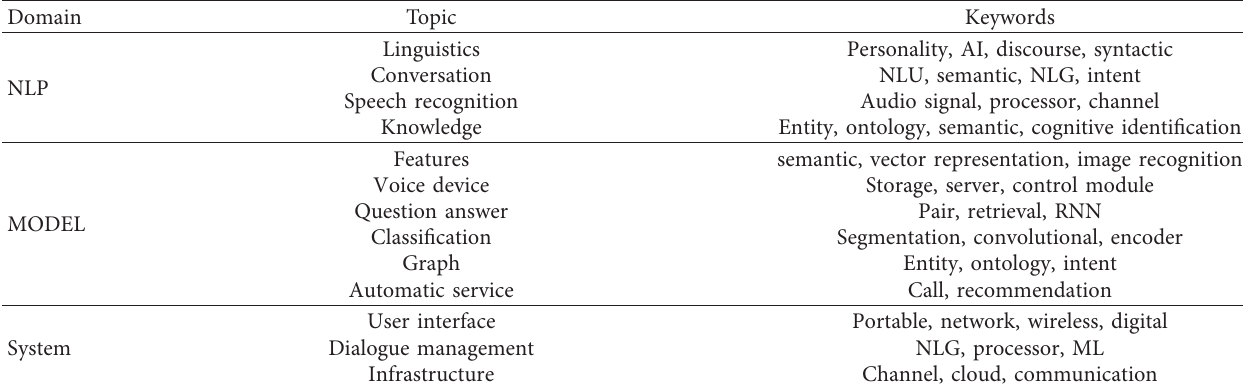
Table 6: Keywords for each